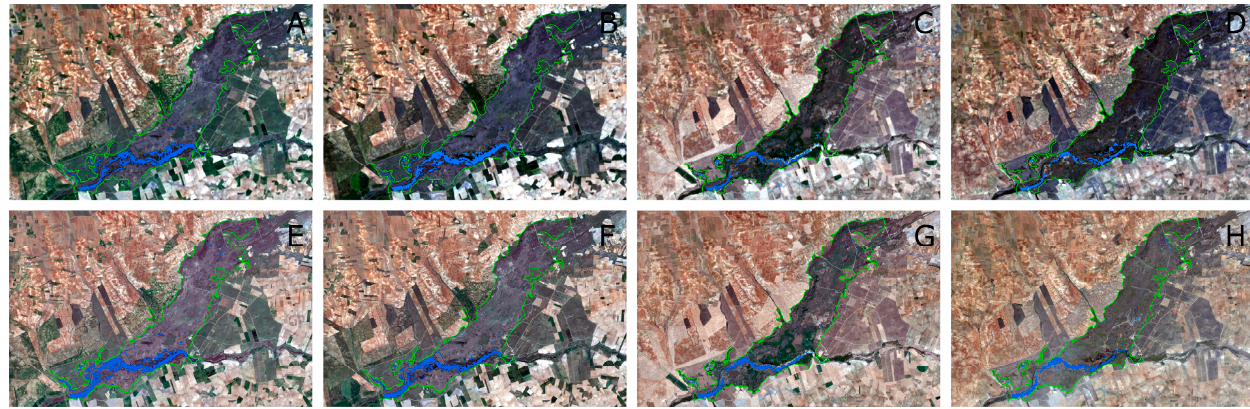
Figure 8. Water bodies in the Tablas de Daimiel National Park delimited according to the MNDWI spectral index for Landsat-8 OLI (threshold − 0.25) and NDWI for Sentinel-2 A/B (threshold − 0.20). Landsat-8 OLI images; ( A ) March 2021, ( B ) April 2021, ( C ) August 2021, and ( D ) October 2021. Sen- tinel-2 A/B images: ( E ) March 2021, ( F ) April 2021, ( G ) August 2021, and ( H ) October